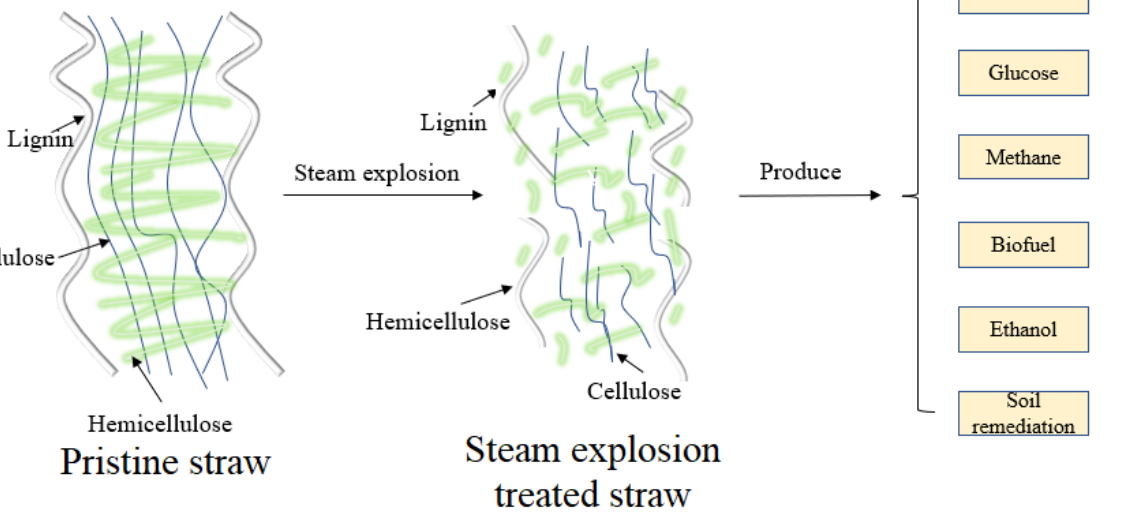
Figure 2. Roles of steam explosion in the production of bioproducts and energy substances.